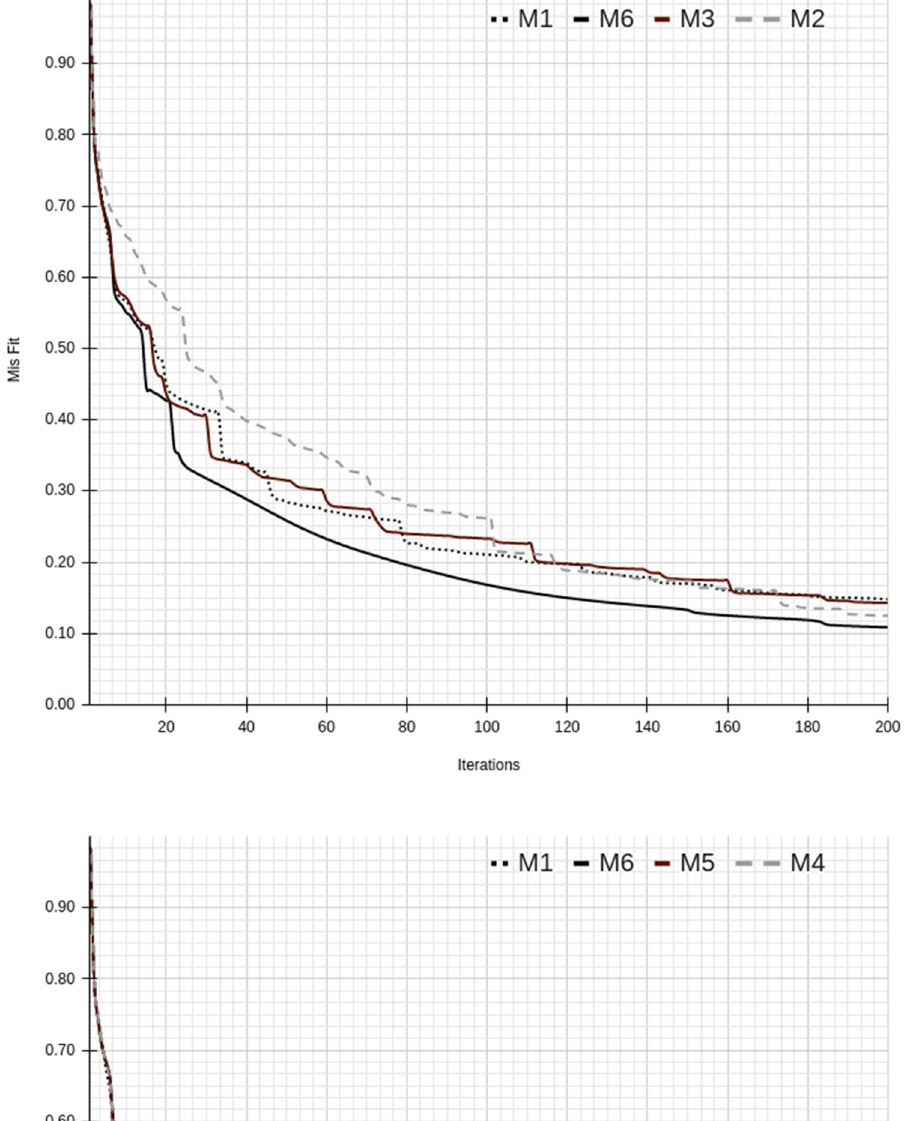
Fig. 6 Illustration of the misfit function for M1, M2, M3 and M6 schemes